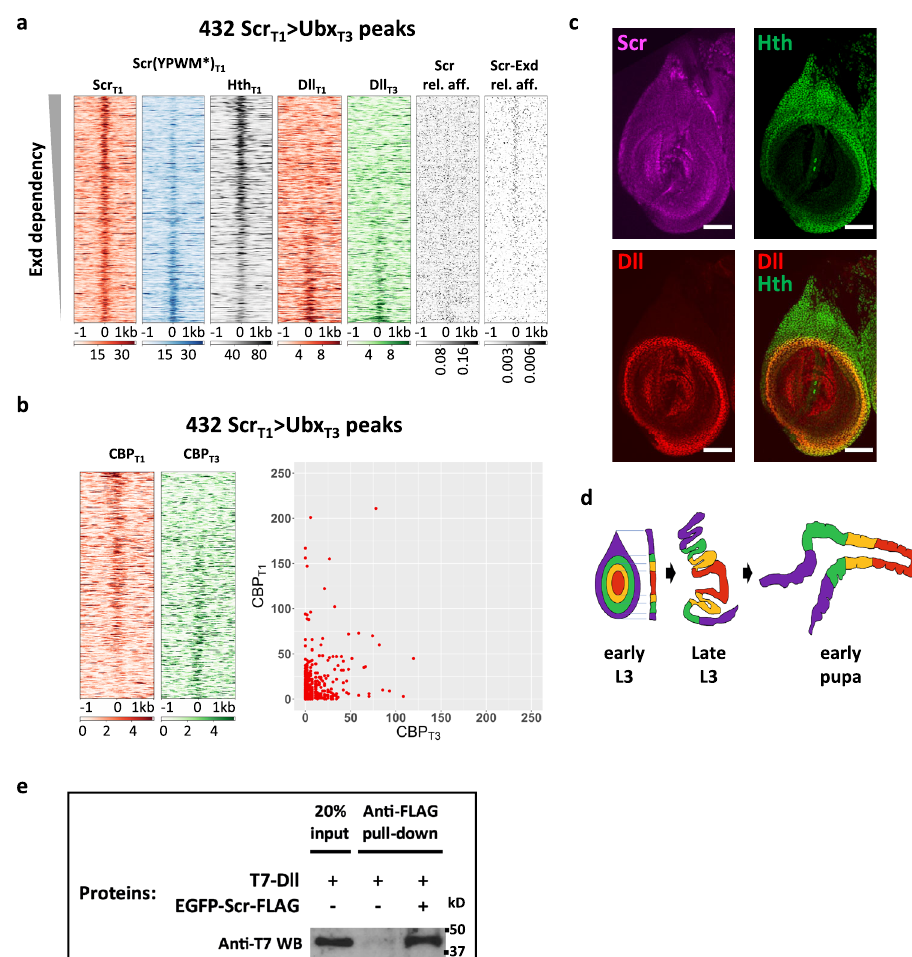
Fig. 5 Exd-dependent and -independent Scr T1 > Ubx T3 peaks. a Heatmaps of the 432 Scr T1 > Ubx T3 ChIP-seq peaks sorted by Exd-dependency, based on the relative intensities of the Scr T1 and Scr(YPWM*) T1 ChIP-seq signals. Also shown are the ChIP-seq signal for Hth in T1 leg disc and the ChIP-seq signals for Dll in T1 and T3 leg discs. The relative af fi nities of Scr monomer (Scr) and Scr-Exd dimers using the respective NRLB models are also plotted. b Heatmaps (left) and scatter plot (right) showing CBP occupancy at the 432 Scr T1 > Ubx T3 peaks in T1 and T3 leg discs. The peaks in the heatmaps are sorted according to the ratio of T1:T3 CBP occupancy. c The expression patterns of Scr (magenta), Hth (green), and Dll (red) in T1 leg imaginal discs. Scale bar: 50 μ m. d Schematic showing the morphological changes of leg discs during metamorphosis. Both top view and lateral cross-section views are shown for the early L3 stage, and the lateral cross-section view is shown for late L3 (wandering stage) and early pupal stages. e Co-immunoprecipitation showing the physical interaction between Scr and Dll. Immunoprecipitation was performed using anti-FLAG antibody and western blot was probed with anti-T7 antibody. This experiment was repeated three times, and one representative result is shown. Source data are provided as a Source Data fi